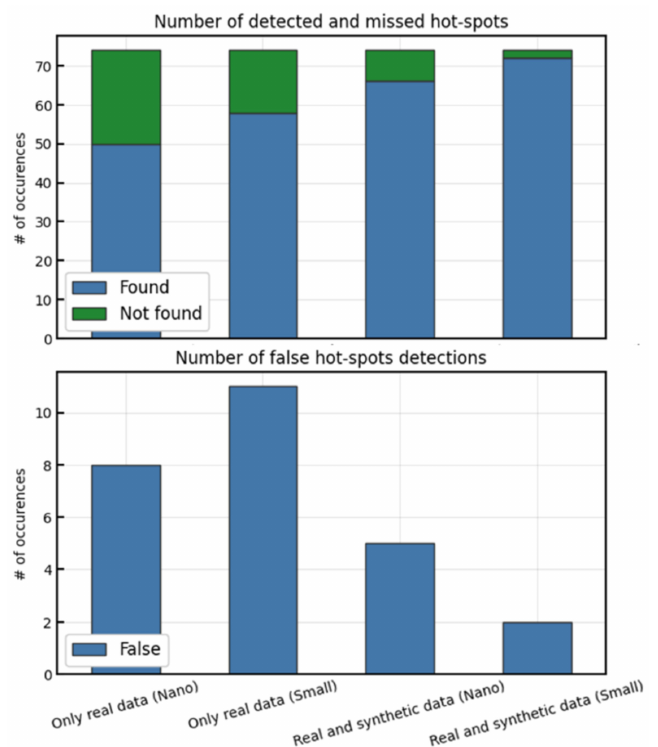
Figure 4. Performance of the models on the 74 never seen real images in the four investigated